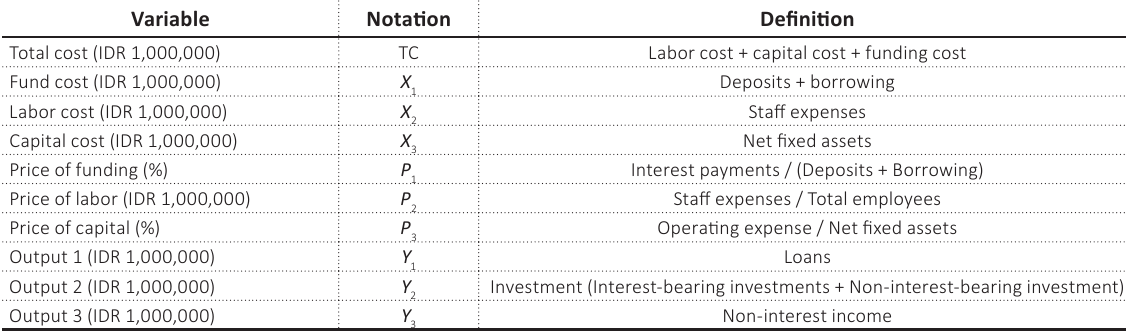
Table 2. Variable definitions of cost function